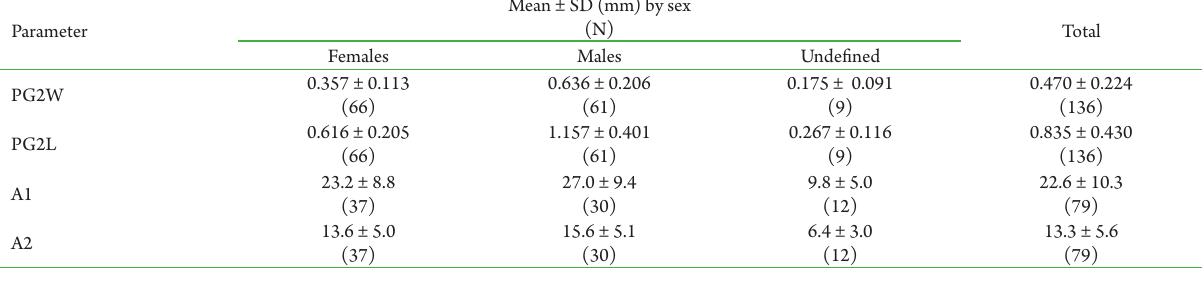
Table 1. Means, standard deviations and number of specimens by sex of Quadrivisio lutzi , which were used to study the allometric growth of the width (PG2W) and length (PG2L) of the propodus of the second pair of gnathopods and of the first (1A) and second (A2) pair of antennal flagella.